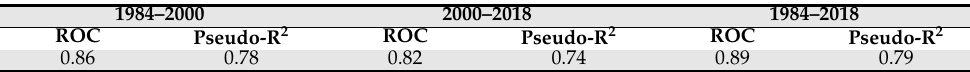
Table 5. Model validation results in terms of ROC and pseudo-R 2 for the probability map.